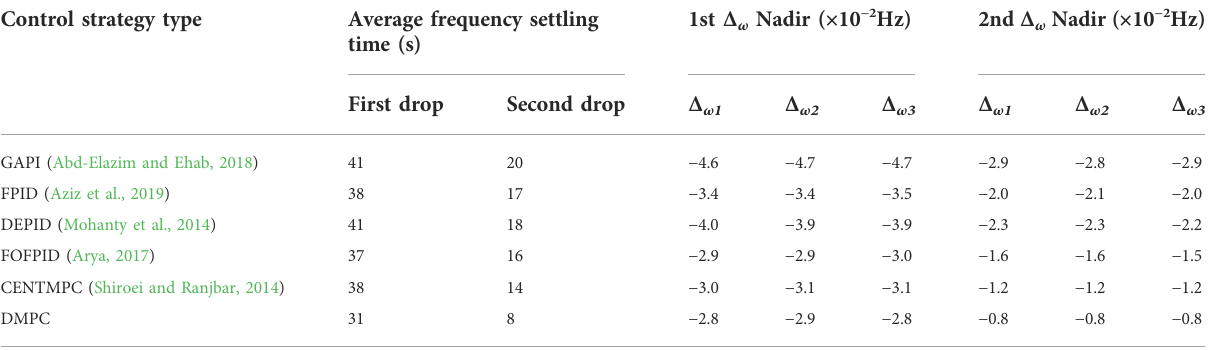
TABLE 5 Test results of AGC performance under different control strategies. Control strategy